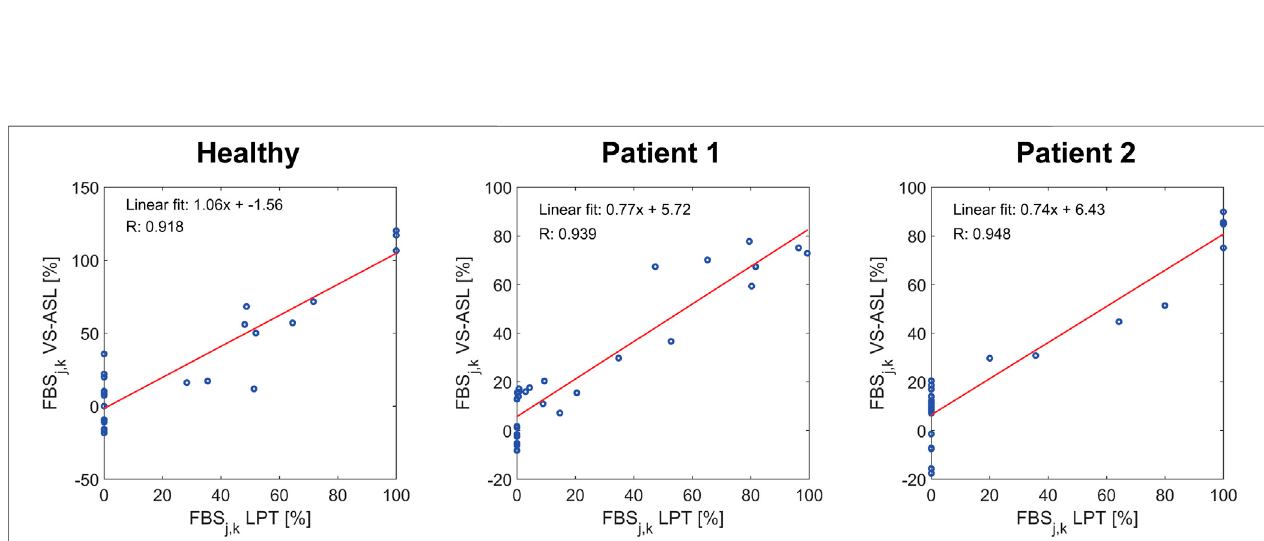
FIGURE6| CorrelationofFBS j,k betweenVS-ASLandLPT.Foreachsubject,thecorrelationcoef fi cientandlinear fi tofFBS j,k overallterritories j andneckarteries k was calculated.